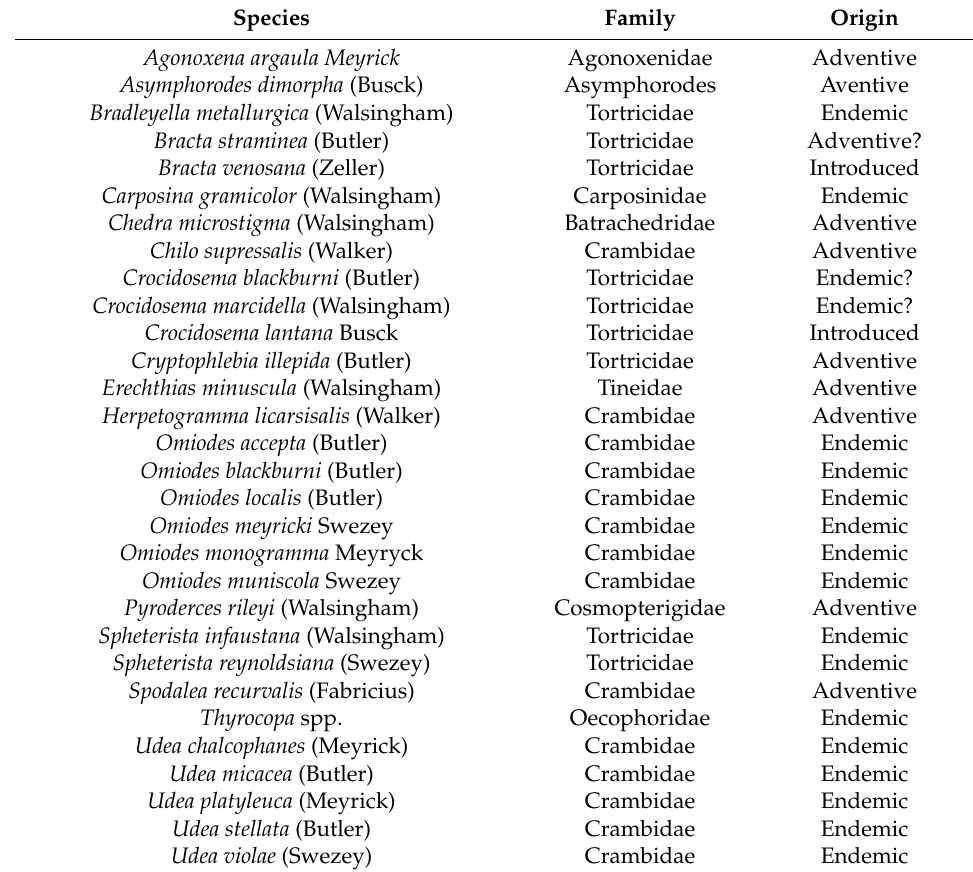
Table 3. List of known hosts of T. flavoorbitalis in Hawaii (adventive = accidental introduction, Introduced = purposely introduced; ? = uncertain)